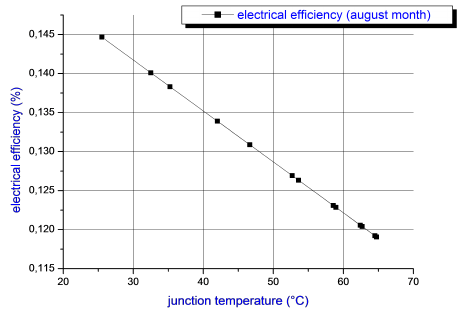
Fig. 10: Evolution of electrical e(cid:30)ciency as a function of the junction temperature for n = 105 under an average sky.